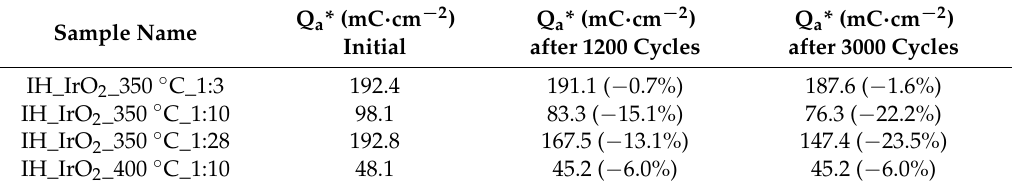
Table 5. Anodic charge density measured during durability study.